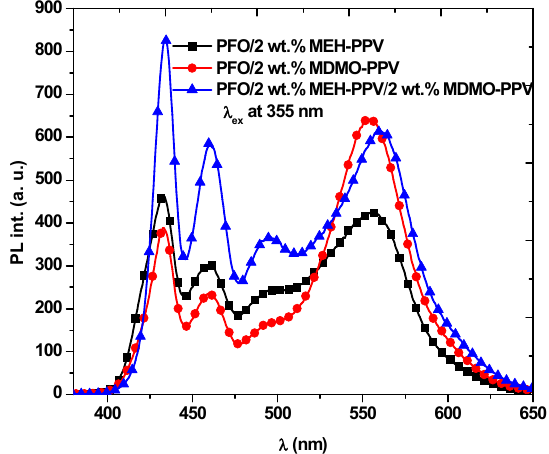
Figure 6. PL spectra of binary and ternary hybrids with the optimum ratios.